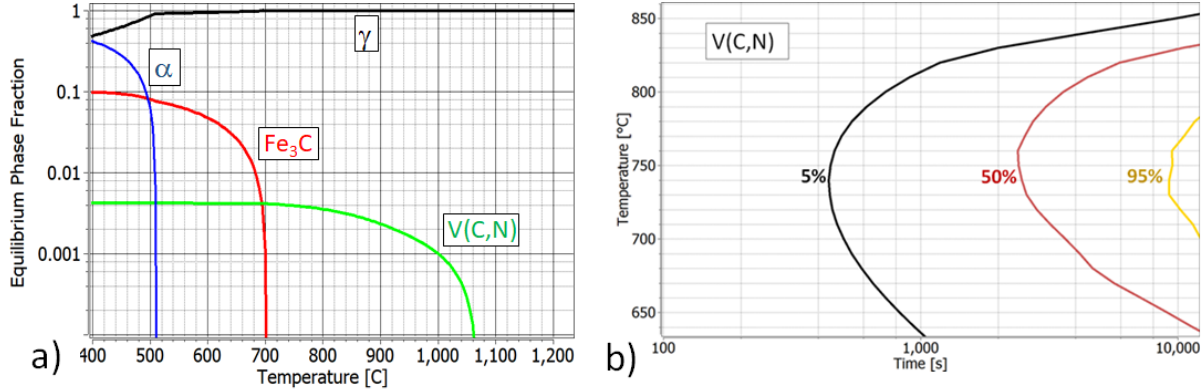
Figure 12. ( a ) Equilibrium volume fraction of V(C,N) precipitated in steel 5A as a function of temperature, ( b ) PTT calculation for V(C,N) in steel 5A assuming nucleation on dislocations with a density of 1 × 10 14 m − 2 .